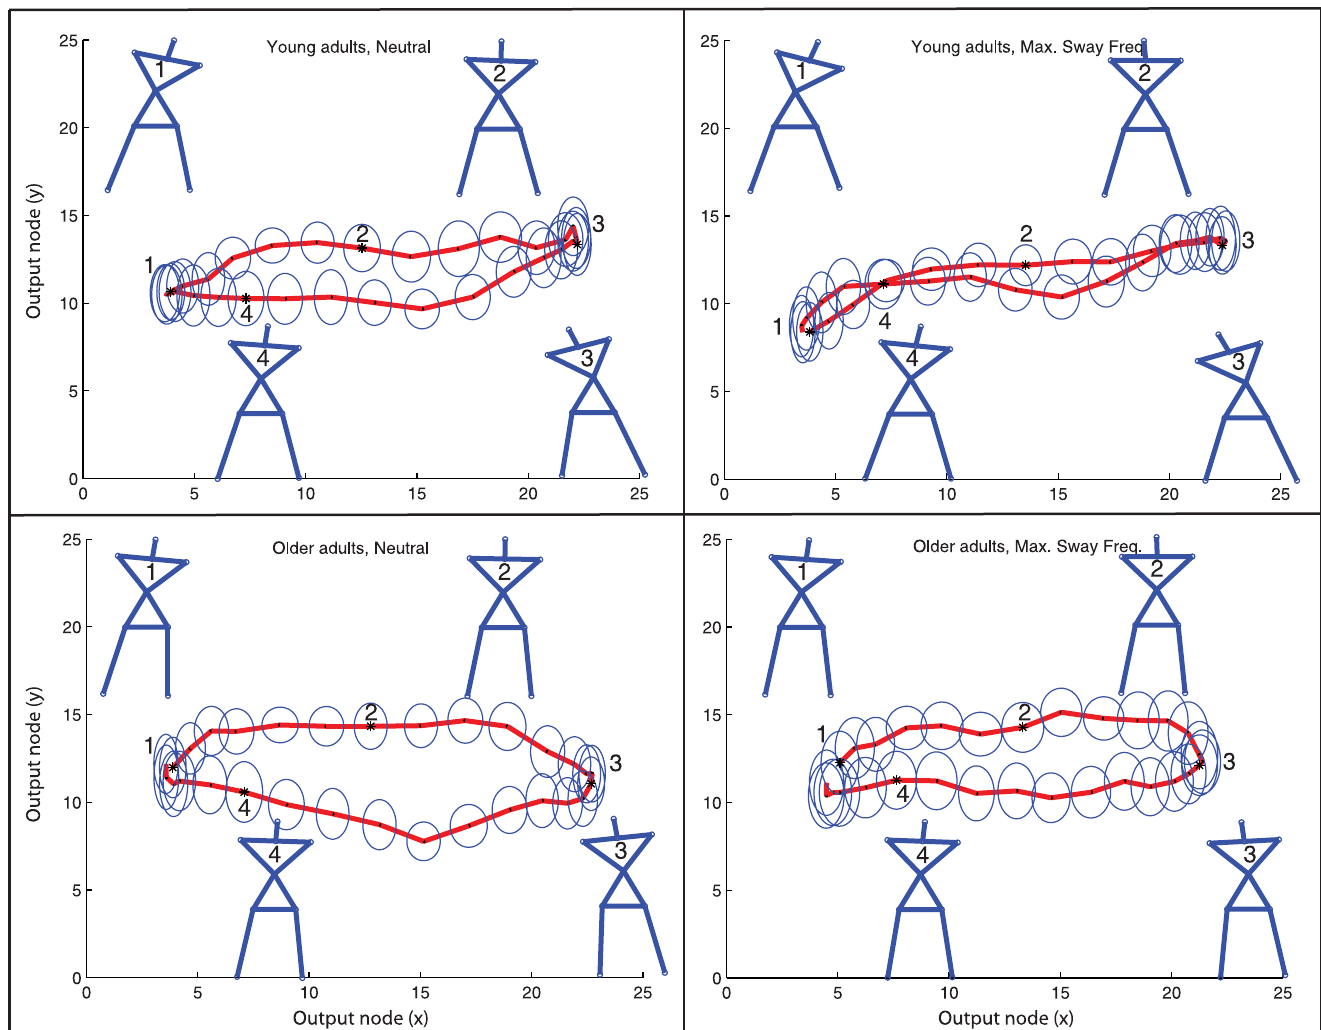
Fig 4. Average BMU trajectories of young and older adults in ‘ neutral ’ and ‘ maximum sway frequency ’ conditions. Average sway trajectories displayed by connecting BMUs of subsequent input posture vectors of all young and older adults (upper and lower panels, respectively) in the neutral game condition and maximum sway frequency condition (left and right panels respectively). Blue circles indicate standard errors of the mean of BMU positions. Stick figures indicate the average adopted postures 1, 2, 3 and 4 captured at 1%, 25%, 50% and 80% of the time of the sway movement, respectively.